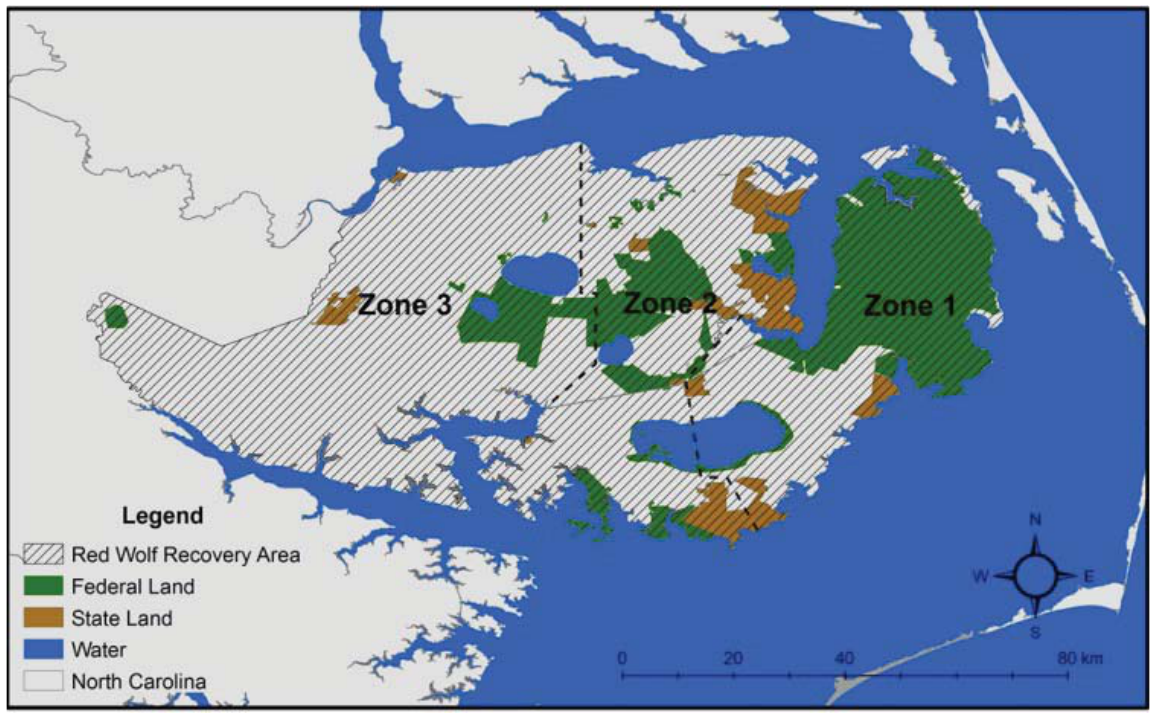
Figure 2. Management zone boundaries within the Red Wolf Recovery Area of northeastern North